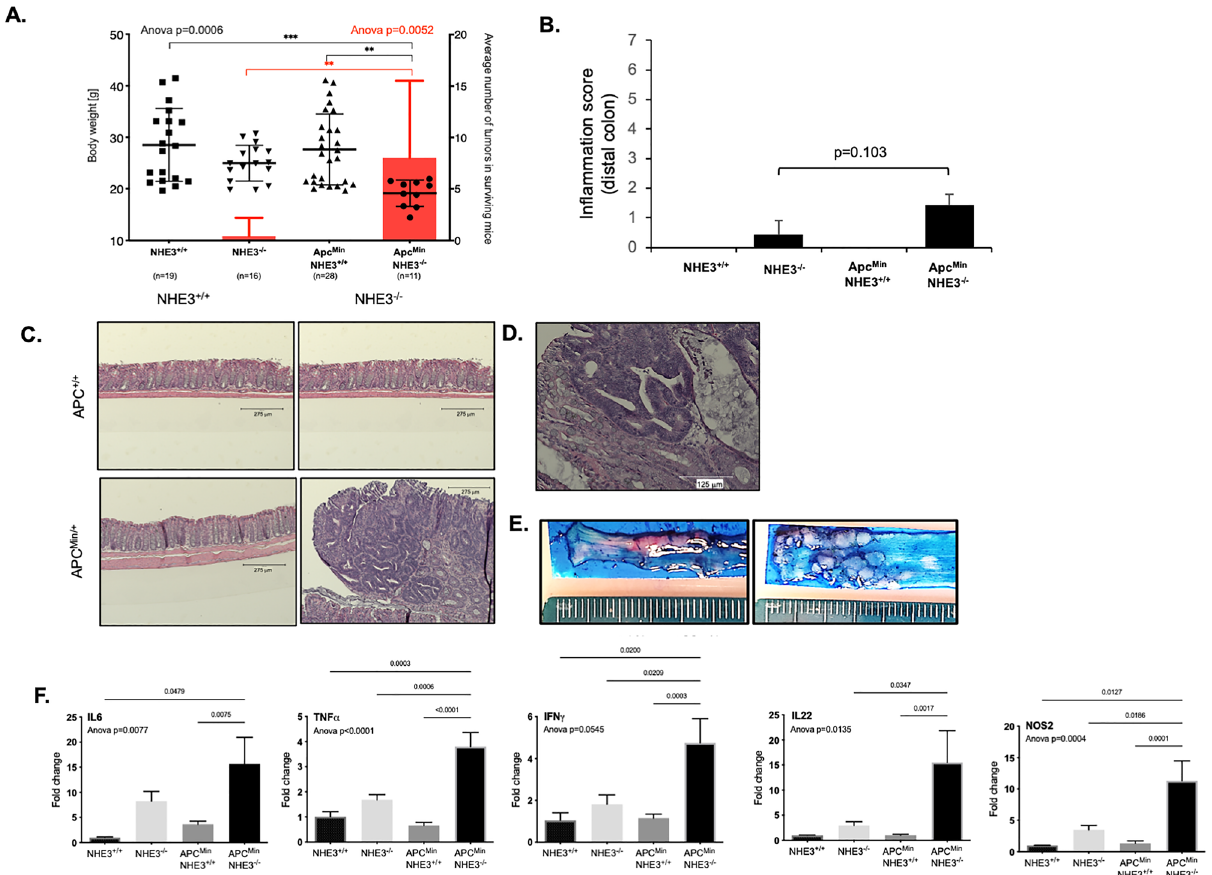
Figure 2. NHE3 expression decreases in human colorectal cancer and increased number of tumors in Apc Min/+ NHE3 −/− mice is associated with lower body weight and increased colonic expression of proinflammatory cytokines. ( A ) Body weights (left Y axis, black symbols) and average number of polyps in surviving mice (right Y axis, red bars). Black symbols represent individual mice with median value marked with bold line; whiskers depict standard deviation. Red boxplots represent the mean values and standard deviations for the number of tumors per mouse. Statistical significance (in black for body weight and in red for the average number of tumors) was calculated using one-way ANOVA followed by Holm-Sidak’s multiple comparison test. ( B ) Bar graph summary of histological colitis scoring (reported p-value from Mann– Whitney test). ( C ) Representative H&E images of the distal colonic mucosa in the four genotypes. ( D ). High magnification representative image of tumor histology in Apc Min/+ NHE3 −/− mice. ( E ) Representative image of methylene blue-stained distal colon with healthy mucosa in Apc Min/+ NHE3 +/+ mice and multiple adenomas in Apc Min/+ NHE3 −/− mice. ( F ) Cytokine expression profile in the distal colon measured by qRT-PCR relative to GAPDH as a housekeeping gene. Statistical differences analyzed with one-way ANOVA followed by Tukey multiple comparison